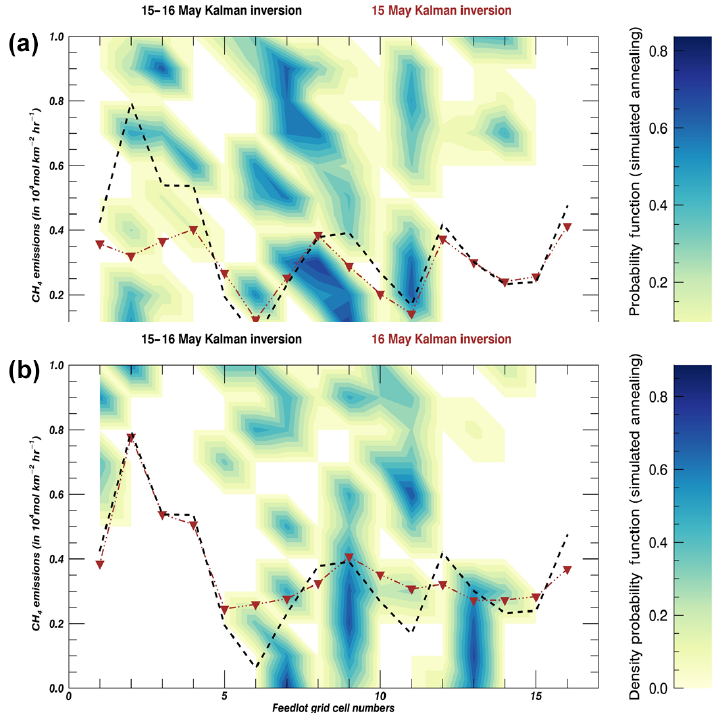
Figure 10. Emissions of CH 4 (in molkm − 2 h − 1 ) for the 16 pixels (2 × 2km 2 shown in Fig. 2) describing the dairies for both days, i.e., 15 January (a) and 16 January 2015 (b) . The probability density function from the simulated annealing is shown in the background. The Bayesian mean emissions (see Sect. 3.2) for the 2 days combined are shown in black (dash line) and for the individual day (brown